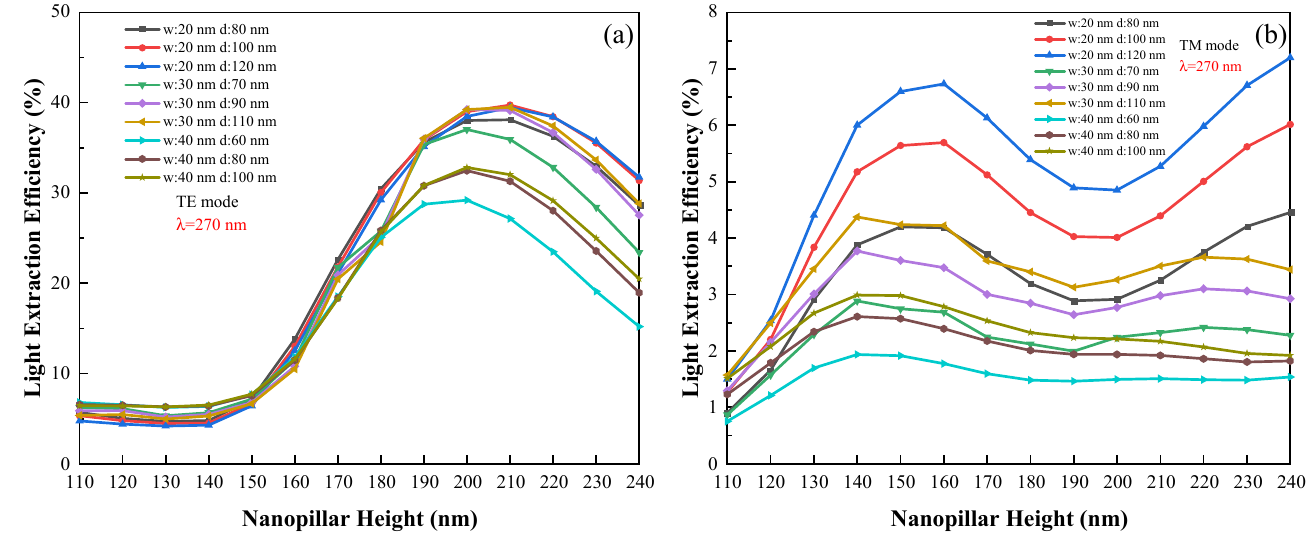
Figure 3. LEE as a function of nanopillar height and widths were set to 20, 30 and 40 nm for ( a ) TE-polarization and ( b ) TM-polarization with emission wavelength of 270 nm.